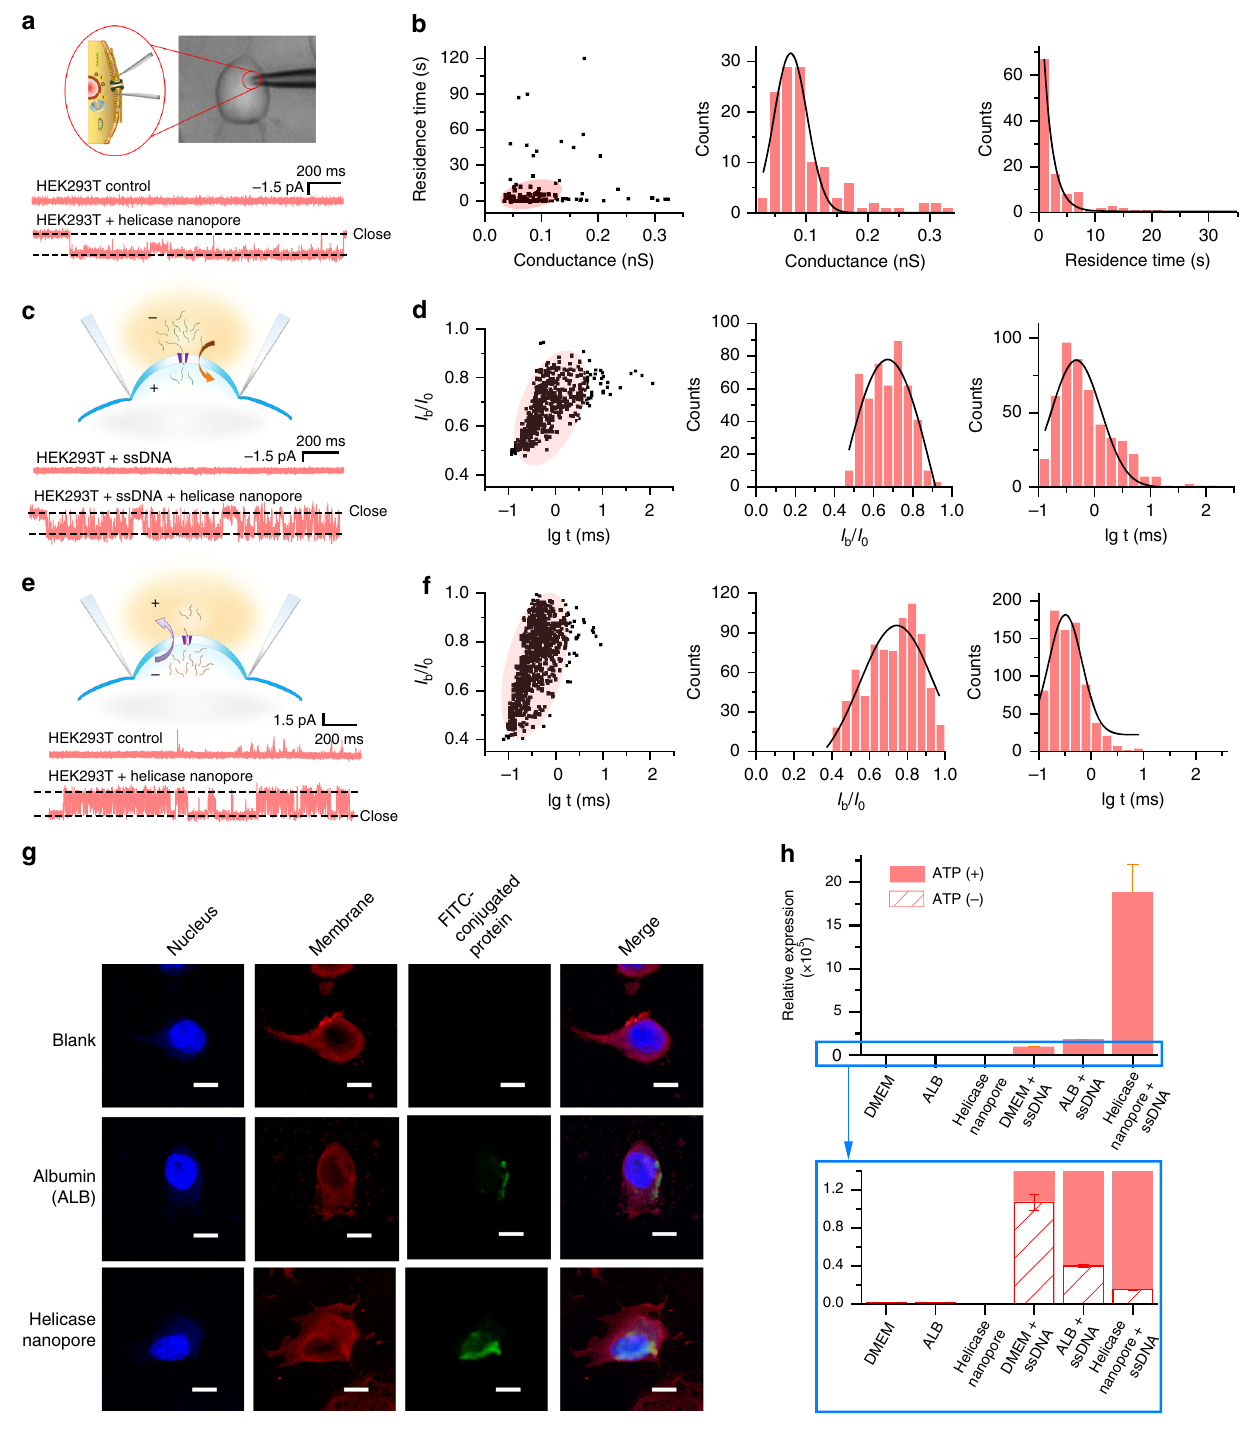
technique to study the ability of the helicase nanopore incor- poration into live cell membranes 17 . The human embryonic kidney (HEK293T) cell line was chosen for the patch-clamp experiments since the cell line had low endogenous channel activity and was widely used in cell electrophysiology research. A patch pipette containing the intracellular solution and the helicase nanopores was used to approach a single live cell (Fig. 4a). After gigaseal was formed, resistance current pulses and the resulting changes in electrical conductance of the patch were monitored. In successfully patched HEK293T cells, the cell membrane exhibited